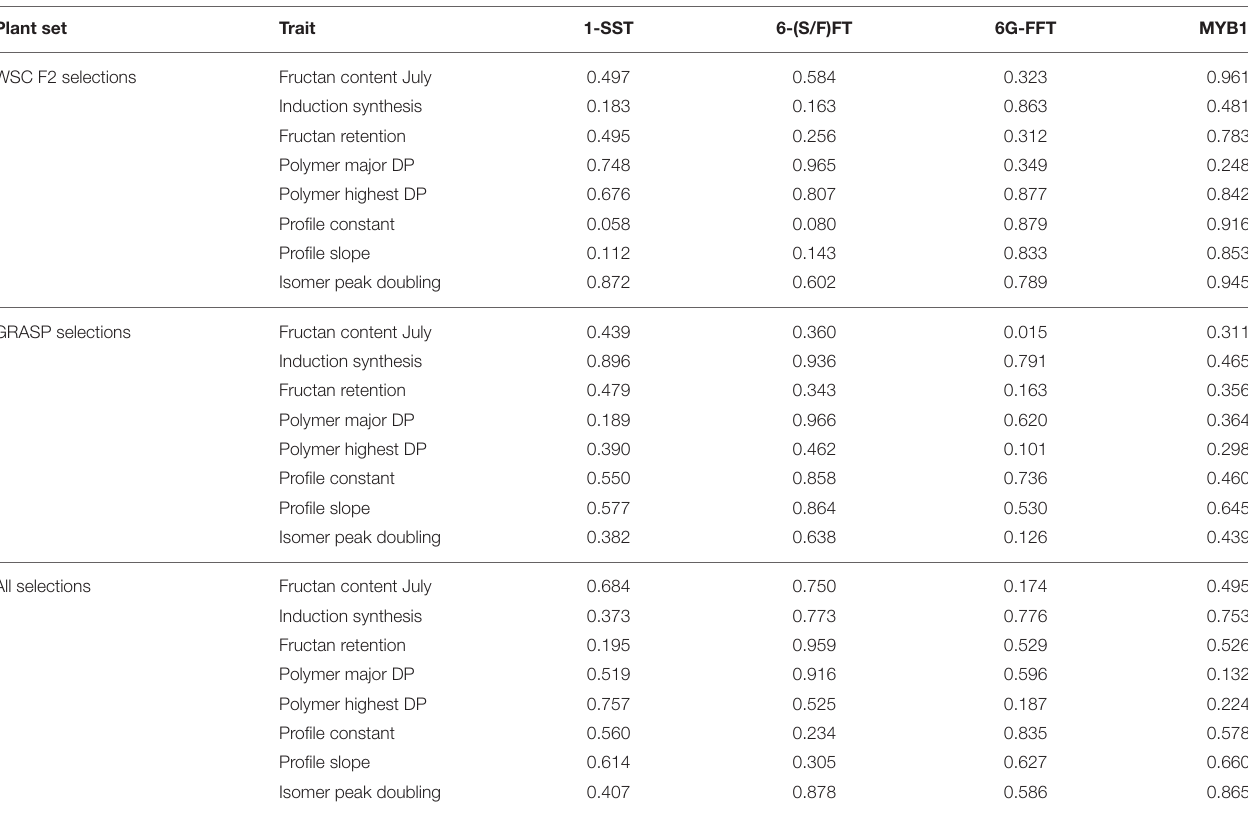
TABLE 7 | Probabilities of significant effects (Genstat FPROB values) for fructan content and fructan polymer profile traits from one-way analysis of variance with marker score (D/S or aa/ab/bb) as a fixed effect. Plant